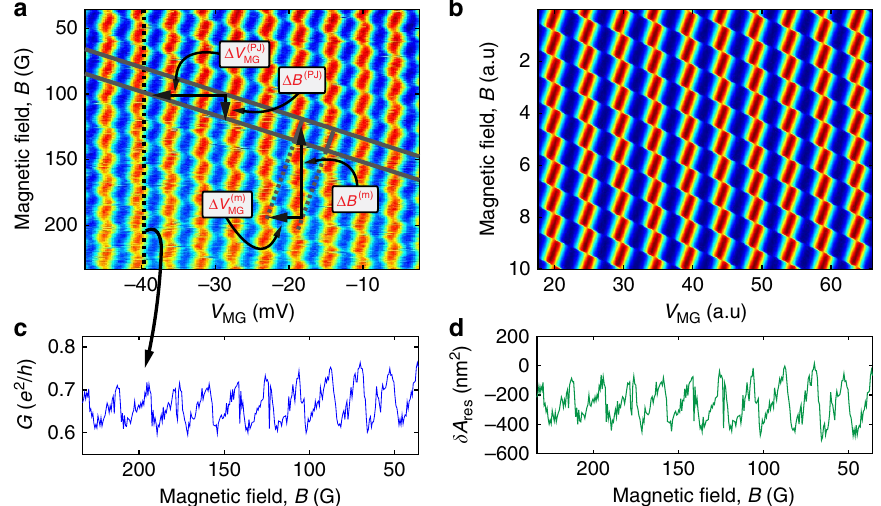
Figure 4 | 2D conductance plot with clear phase jump lines. ( a ) Conductance is measured with the same device as Fig. 3, but with substantially higher and D B (PJ) . transmission ( o t 4 E 0.7). Phase jump lines are marked by solid descending lines and the frequency defined by their slope is marked by D V PJ ð Þ MG In between adjacent phase jump lines, we have continuous conductance oscillations. By extrapolating these continuous oscillations (dashed ascending lines), we may attribute them periodicities denoted D V m ð Þ and D B (m) . More details are provided in analysis. ( b ) Theoretical plot, simulated according to the MG conductance G expressed in Discussion. ( c ) Constant d V MG line taken from a , showing clear phase accumulation followed by abrupt phase jump of D y ¼ 0 : 75, which is also equal to the value of x (equation (11)). ( d ) The area response d A int inferred from the conductance’ phase ( c ). The relation between 2 p the area response and the phase is obtained by inverting the relation between d A int and the conductance G , provided in the caption of Fig. 5. Note that indeed ( c , d ) are highly similar (as anticipated by the theoretical plots, cf. yellow curves in Fig. 5d,b), but they are not identical. Naturally, for small values of the phase, the conductance is nearly proportional to